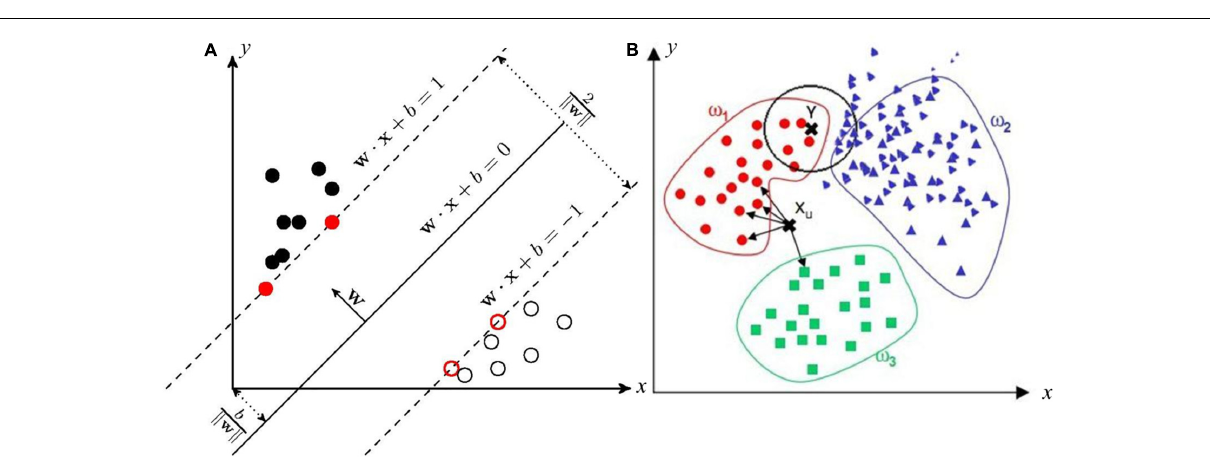
SVM for components in the NPP. In 2017, Chen and